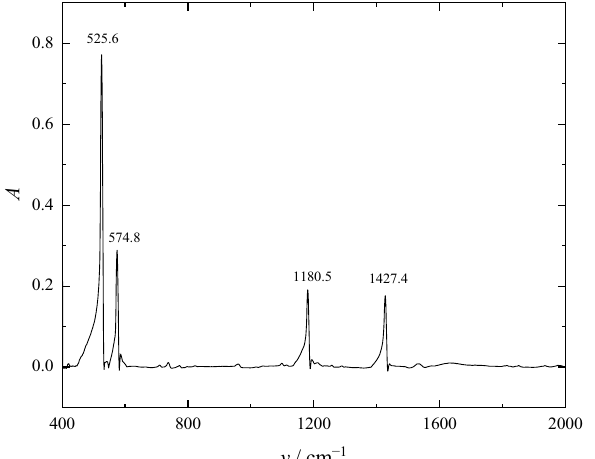
Figure 3. IR spectrum of C 60 fullerene.